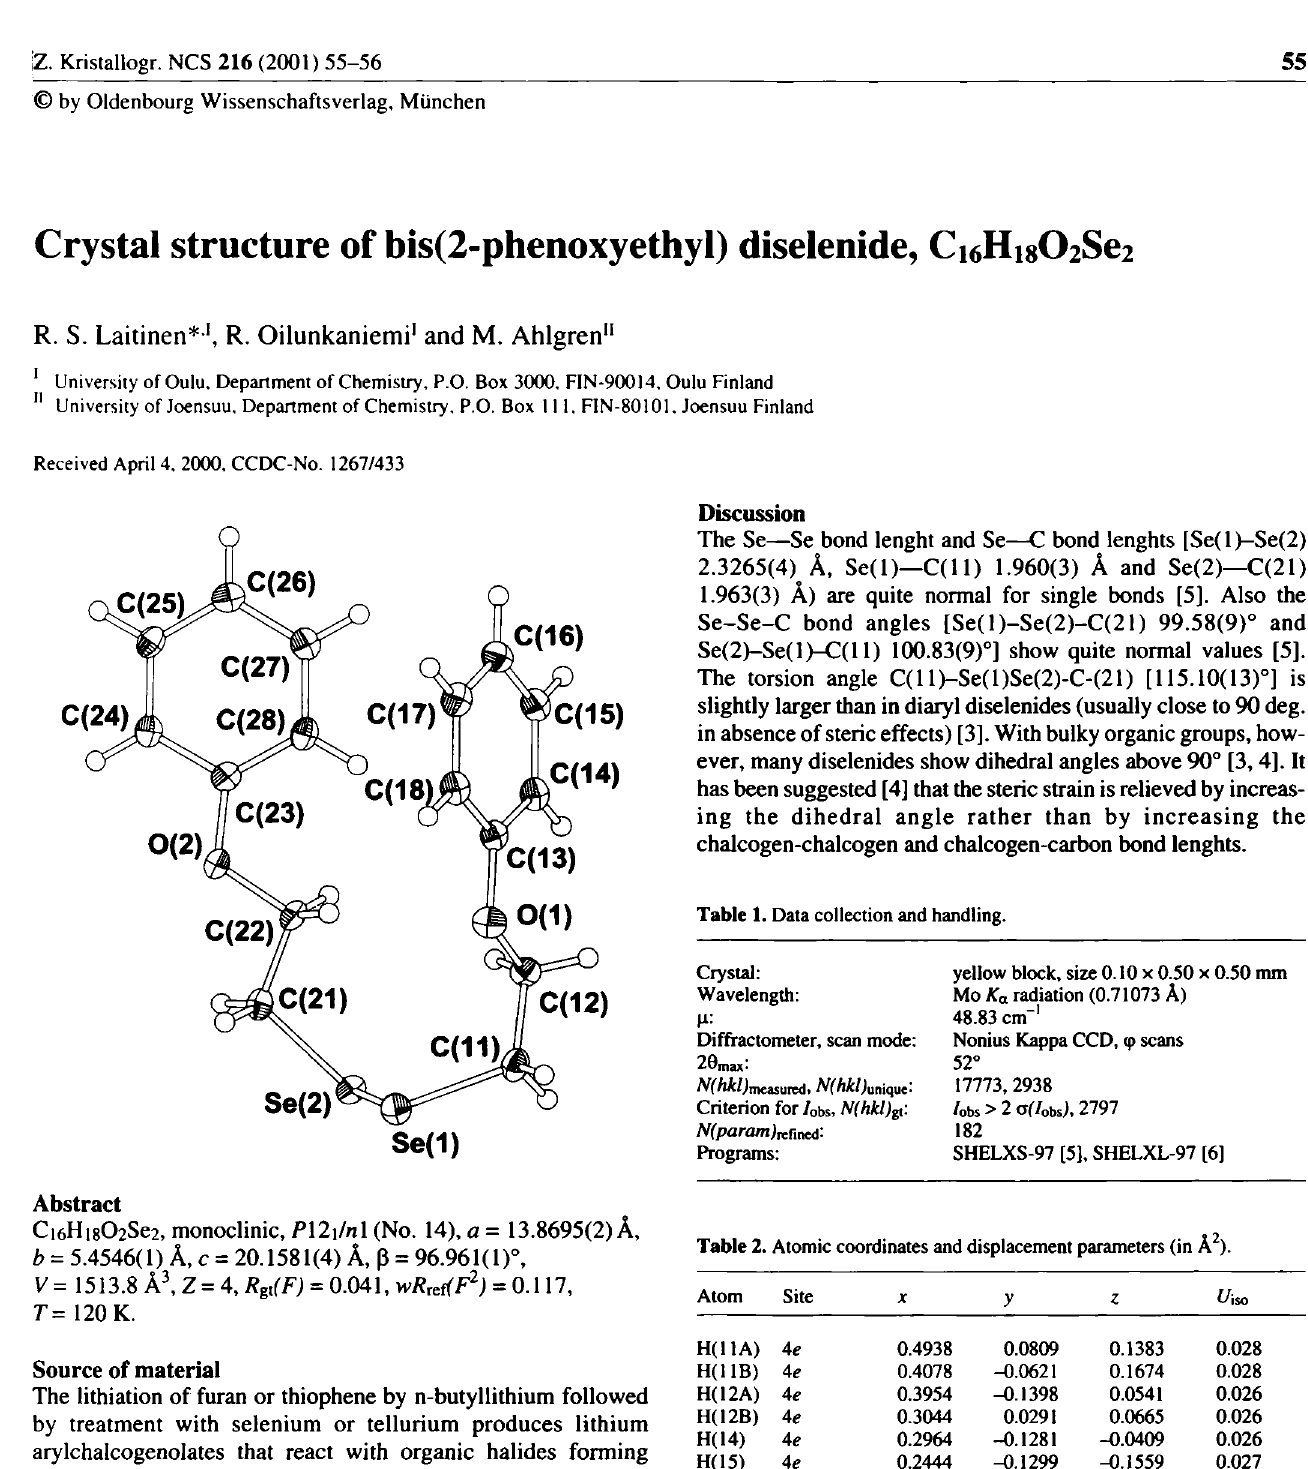
Table 2. Atomic coordinates and displacement parameters (in Ä 2